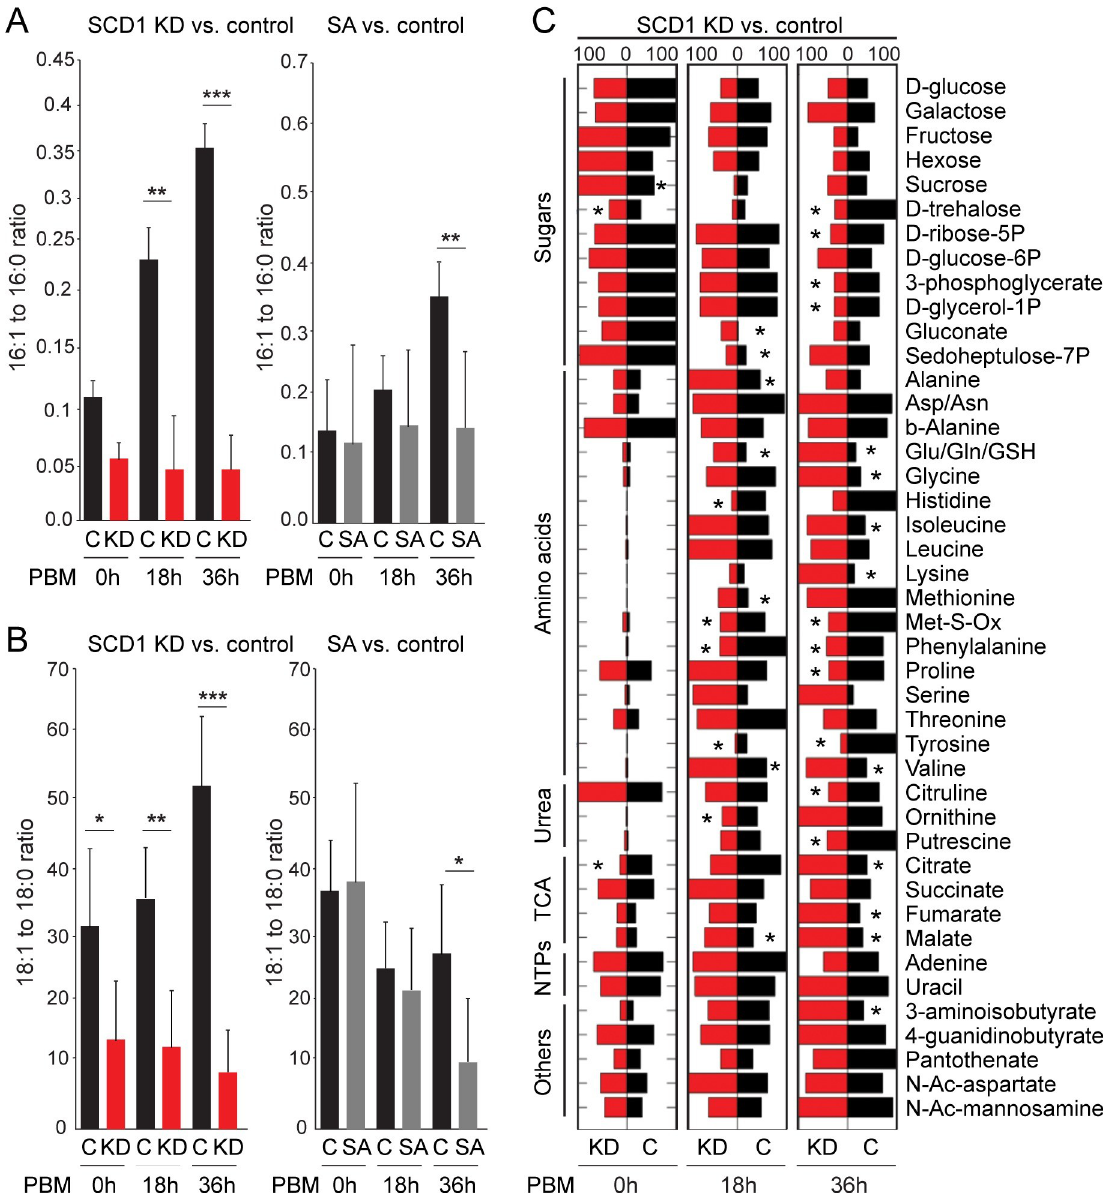
Fig 4. Metabolic responses in blood fed SCD1 KD and SA treated mosquitoes. Desaturase indices ( A ) 16:1/16:0 (Palmitoleate to Palmitate) and ( B ) 18:1/18:0 (Oleate to Stearate) in SCD1 KD (left) and SA-treated (right) adult female mosquitoes prior to (0h) and 18h and 26h post bloodmeal (PBM). DsLacZ injected and 1mM Tris treated mosquitoes were used as controls for SCD1 KD and SA-treatment, respectively. Reported values are mean ± SE of 5 independent biological replicates, where n = 3 mosquitoes per group per replicate. � p < 0.05, � p < 0.001, ��� p < 0.0001 using the student’s t-test. ( C ) Metabolite profiles in SCD1 KD and SA-treated mosquitoes and their respective dsLacZ and 1mM Tris treated controls. Only metabolites which showed statistically significant ( � p < 0.01) changes in the percentage of metabolite signals in the experimental group compared to the control group in at least one of the conditions are shown in the heat map. Red bars represent the mean percentage of metabolite signals in SCD1 KD or SA treated mosquitoes from 5 independent biological repeats. Black bars show mean percentage of metabolite signals in respective controls. stearate) at all time points ( Fig 4B ). A statistically significant reduction in both 16:1/16:0 and 18:1/18:0 indices was also observed upon SA treatment albeit only at 36h PBM. These data confirm that silencing SCD1 or inhibition of the desaturase activity blocks the conversion of